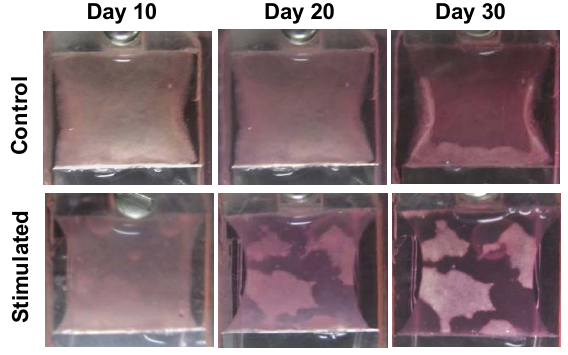
Figure 4 Close-up photographic images of the top view of constructs on days 10, 20, and 30, showing the change in the appearance of the control and load-stimulated constructs over time in